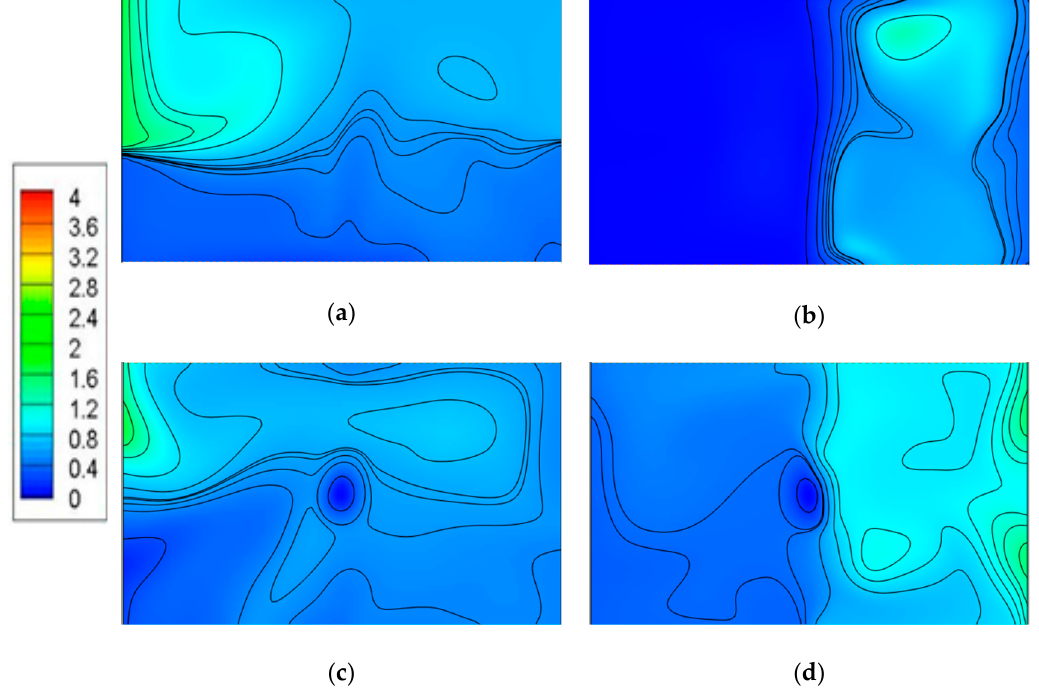
Figure 10. CO 2 concentration cloud map of Z = 1.6 m section: ( a ) Case 1, ( b ) case 2, ( c ) case 3, ( d ) case 4.